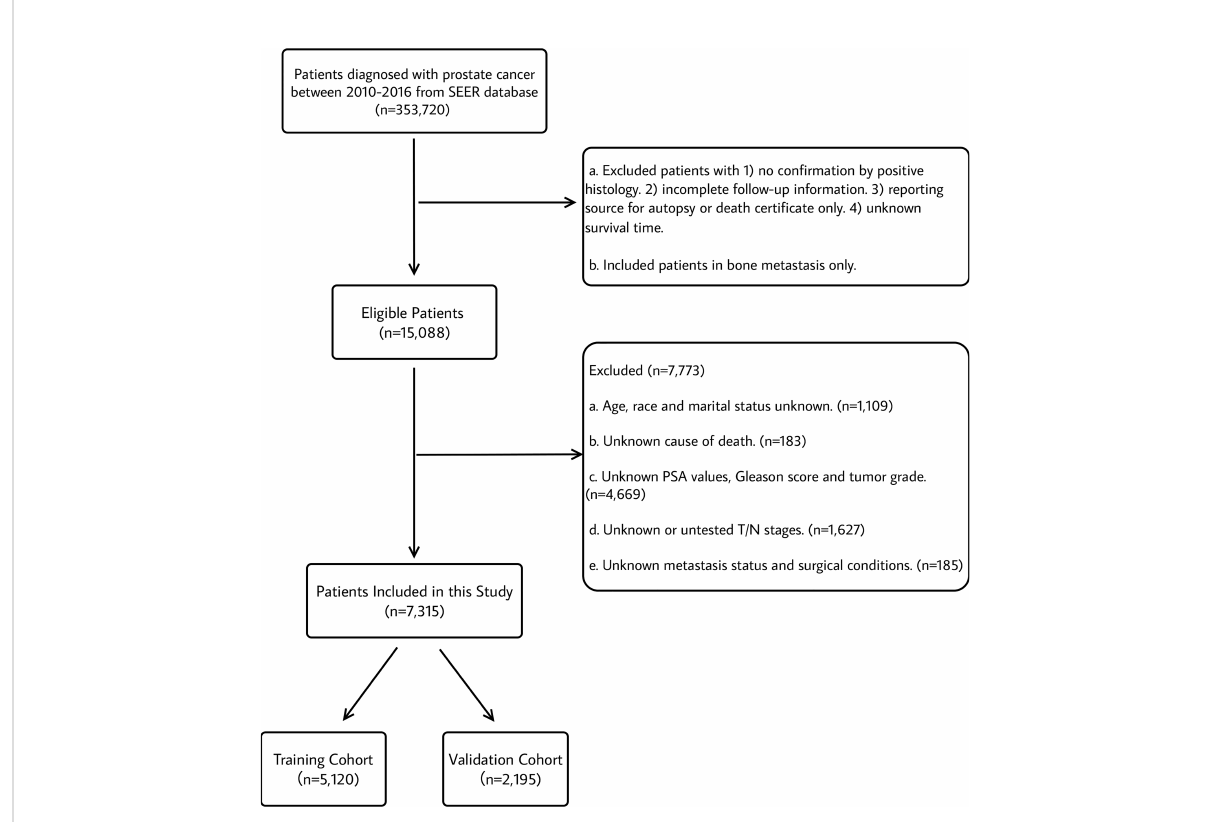
FIGURE 1 Flowchart describing the selection of patients in the Surveillance, Epidemiology, and End Results (SEER) database, 2010 –